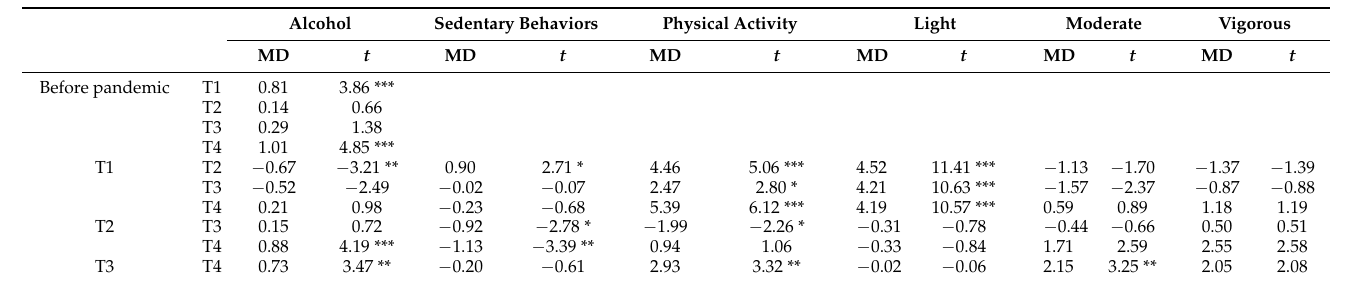
Table 3. Post-hoc comparison.